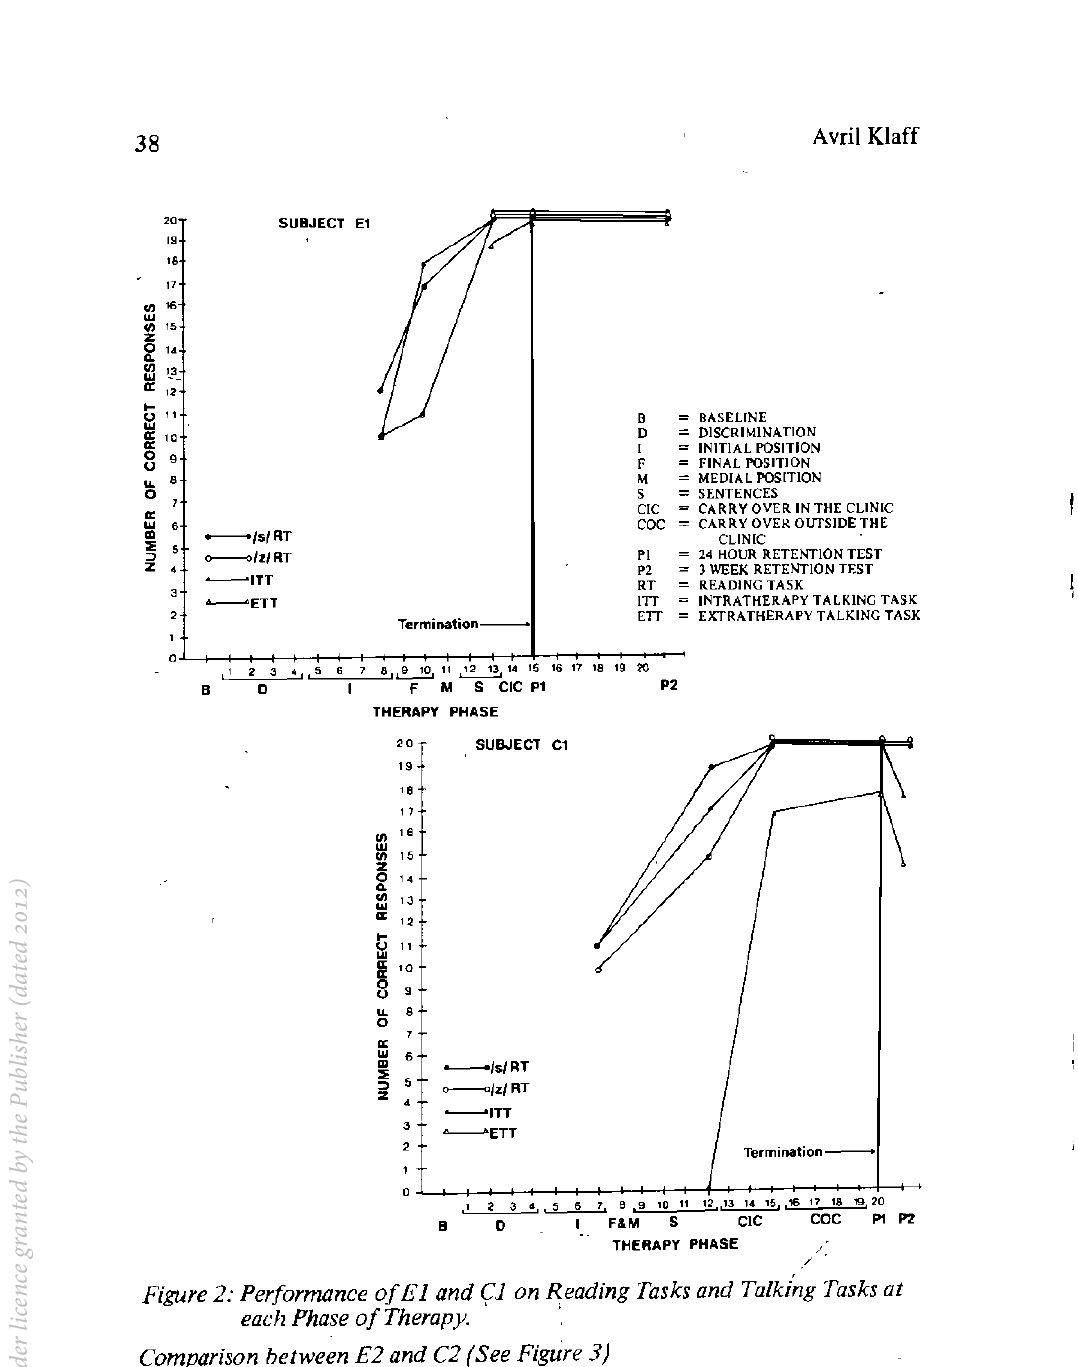
Figure 2: Performance of El and CI on Reading Tasks and Talking Tasks at each Phase of